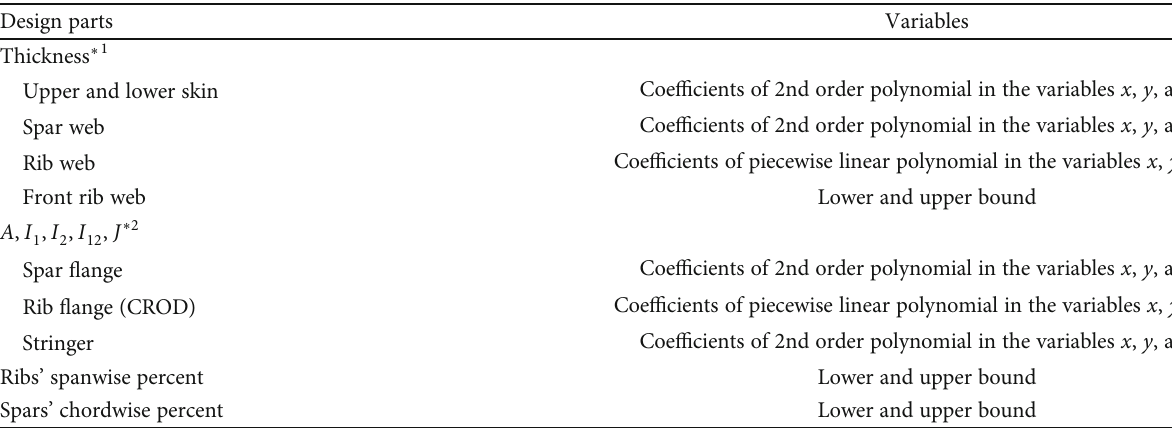
Table 1: Design variables of the wing.